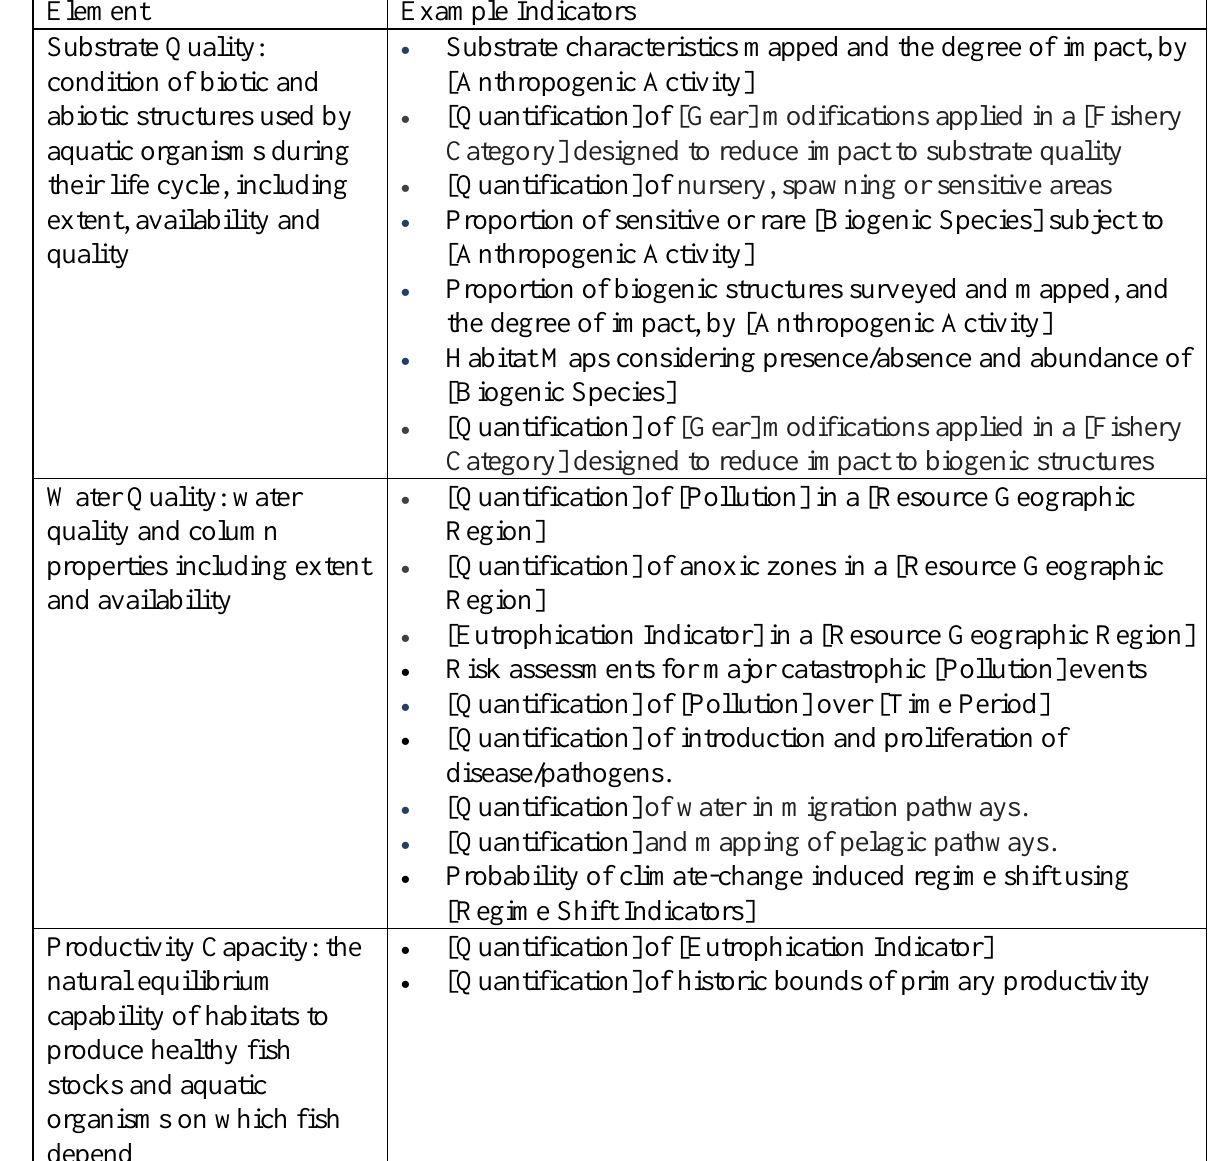
Table A1.5: Habitat & Environment Dimension – Example Indicators Element Example